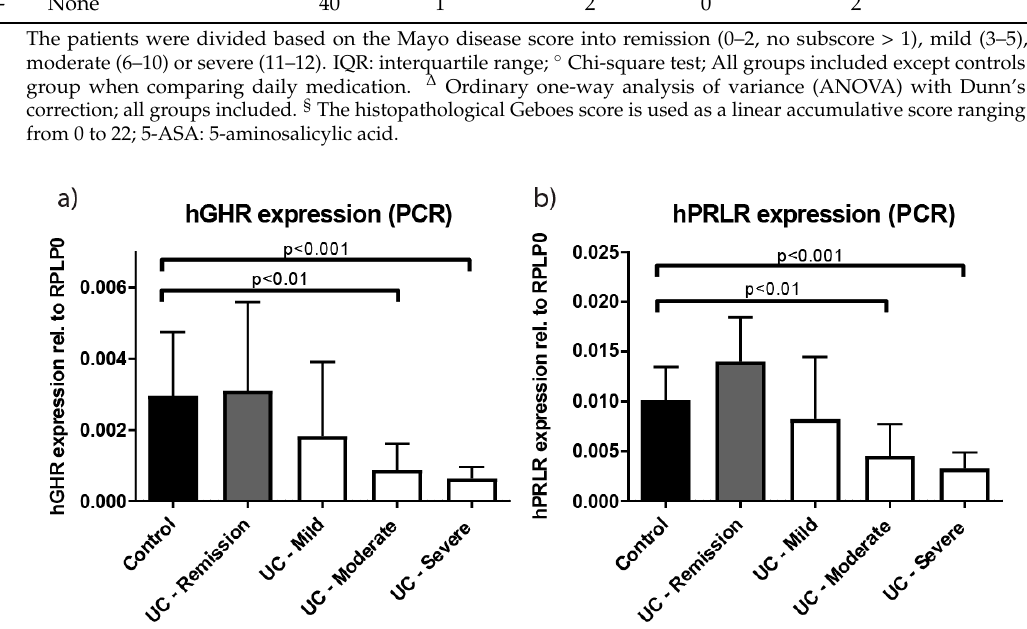
Figure 1. Gene expression levels (qPCR) of human growth hormone receptors (hGHR) ( a ) and human prolactin receptor (hPRLR) ( b ) in colonic biopsies from healthy controls (black), ulcerative colitis (UC) patients in remission (grey) or with active disease (white). A significant reduction in both RNA transcripts was observed for UC patients with moderate and severe disease compared to controls. Data presented as mean ± SD. Statistics: Kruskal–Wallis, Dunn’s correction, comparing all groups to